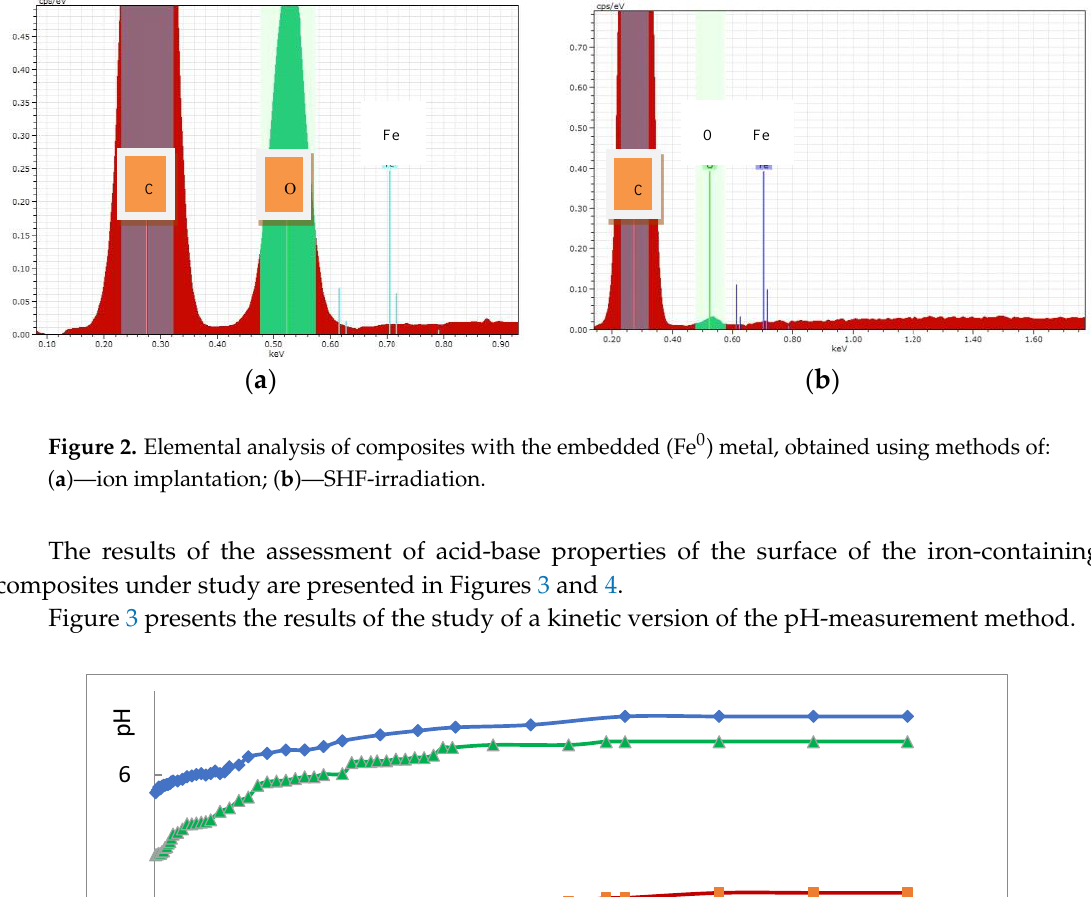
( b ) Figure 1. SEM-image of the polypropylene fiber with fixed Fe 0 particles using SHF-irradiation ( a ) and II ( b ) methods. Figure 1 shows that the distribution of the metal-modifier on the surface of the PP fiber is not uniform enough for all cases of modification. However, it is possible that a more uniform distribution over the surface is observed for iron nanoparticles in the composite obtained using SHF-irradiation. Elemental analysis showed the content (%, mass.) of the metal-modifier in the composites. These results are in Table 2 and Figure 2. Table 2. Average content of nanoparticles Fe 0 in samples of composites. Modification Method Average Content of the Metal in a Sample, % mass. Ionic implantation 0.188 SHF-irradiation